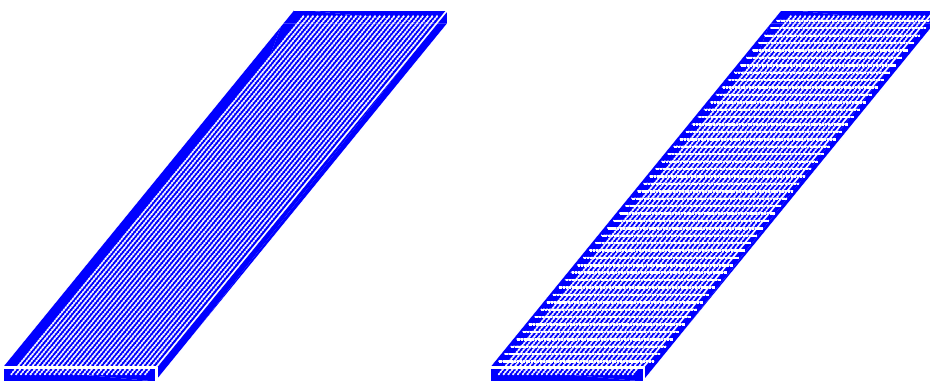
Figure 1. Composite with one-directional fabric ( left ), bi-directional fabric ( right ).